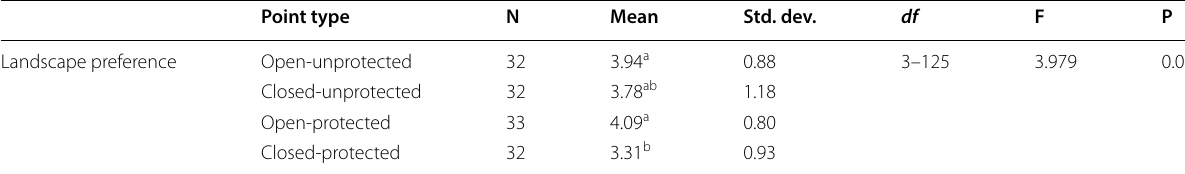
a, ab, b Groups in Tukey’s test (“a” indicates the most preferred group whereas “b” is the least preferred group)